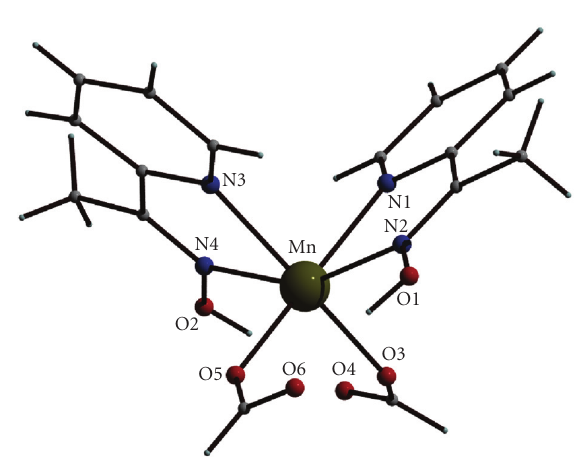
Figure 2: The molecular structure of compound 2 .